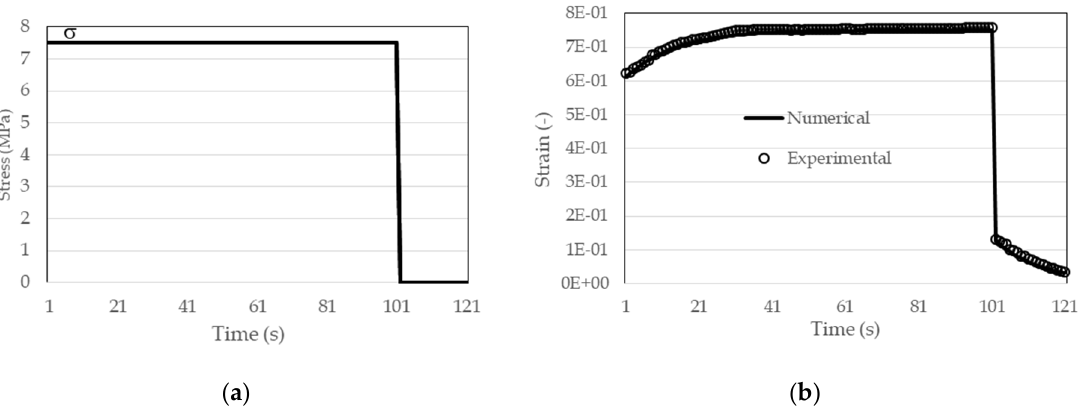
Figure 17. ( a ) Creep recovery test; ( b ) results of creep recovery test.